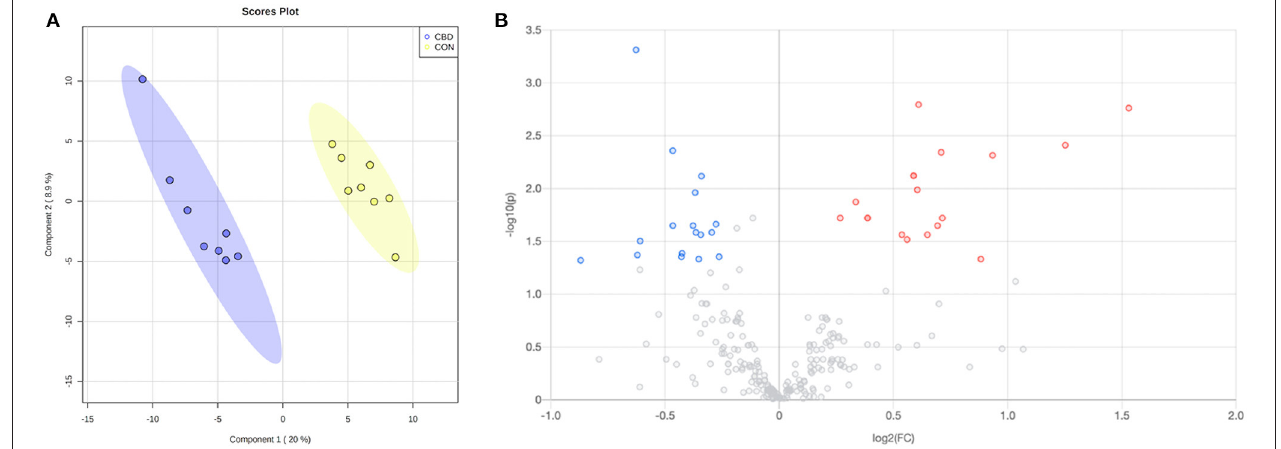
FIGURE 1 | (A) Partial least squares discriminant analysis (PLS-DA) scores plot and (B) volcano plot showing the differential amine/phenol-containing metabolites. Fold change (FC) ≥ 1.2 (in red) or ≤ 0.83 (in blue) with false discovery ratio (FDR) ≤ 0.05 are differentially increased or reduced by cannabidiol (CBD) relative to control